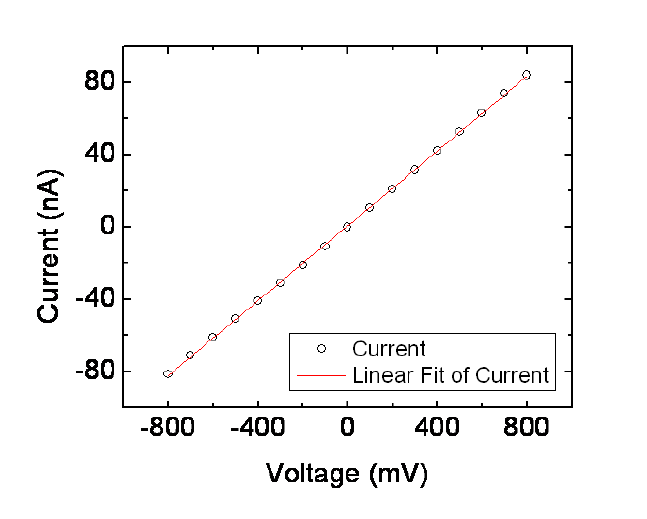
Figure 5. Current voltage characteristics of a 10 µm diameter solid state pore obtained at 0.001M KCl for the Candida albicans detection and configuration experiments. Curve demonstrates Ohmic I-V dependence. Its unobstructed conductance is found to be 100 nS. Error bars are too small to